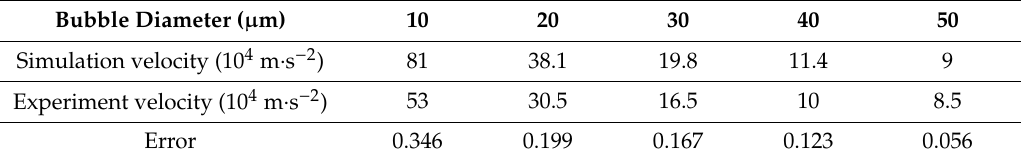
Figure 6. The maximum velocity comparison curves between the experiment and simulation. Table 6. Physical parameters for numerical computation.